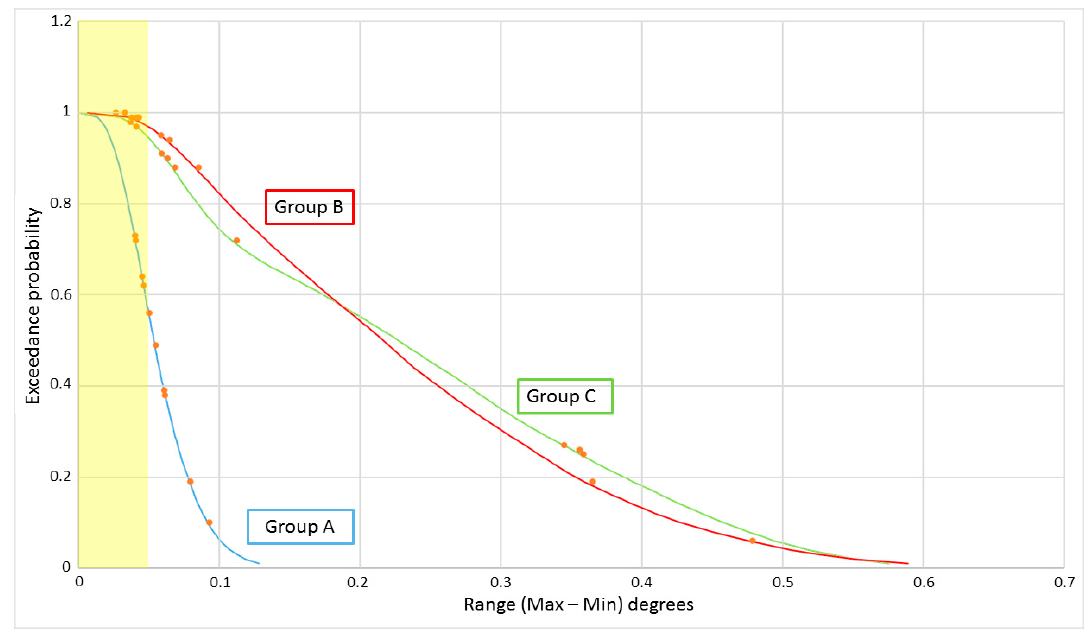
Figure 10. Exceedance plots for pitch error ranges for Groups A, B, and C. Table 3. Pitch 𝑷 𝟓𝟓 values. The maximum values are the average of the peak pitch values for the five repetitions in each group.